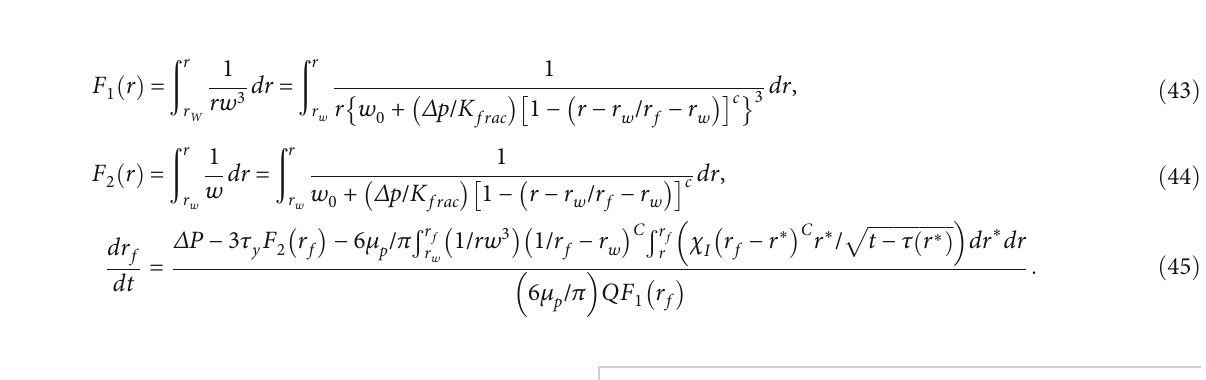
ffiffiffiffiffiffiffiffiffiffiffiffiffiffiffiffiffi t − τ r ∗ ð Þ